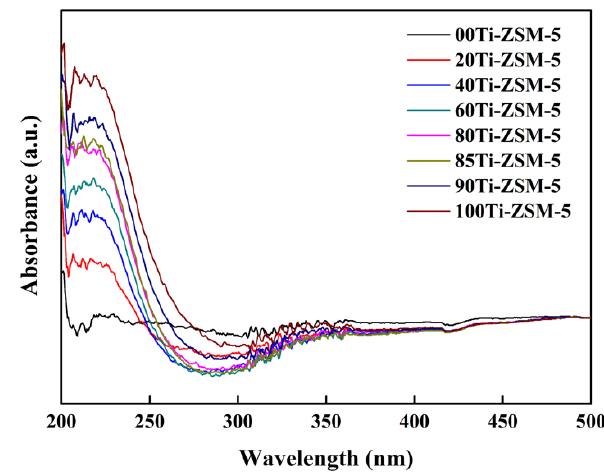
Figure 2. Di ff use reflectance UV-Vis absorbance spectra of hierarchical porous Ti-ZSM-5. Figure 2. Diffuse reflectance UV-Vis absorbance spectra of hierarchical porous Ti-ZSM-5. Table 1. Element molar ratio in gel and surface of hierarchical porous Ti-ZSM-5.